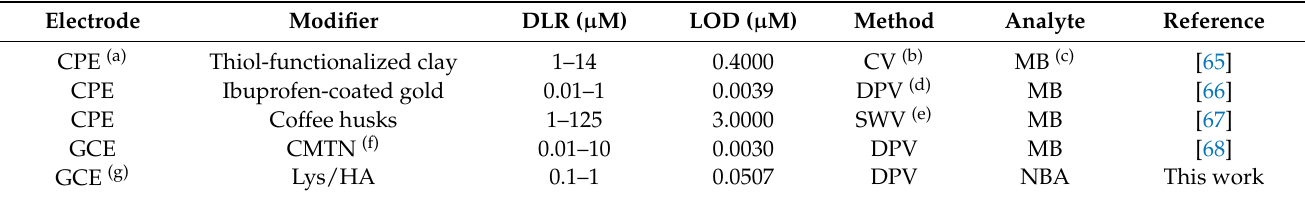
Table 3. Comparison of the performances of the developed sensor GCE/Lys/HA with respect to the electroanalysis of Nile blue A, with those of other modified electrodes applied to the electroanalysis of similar analytes.